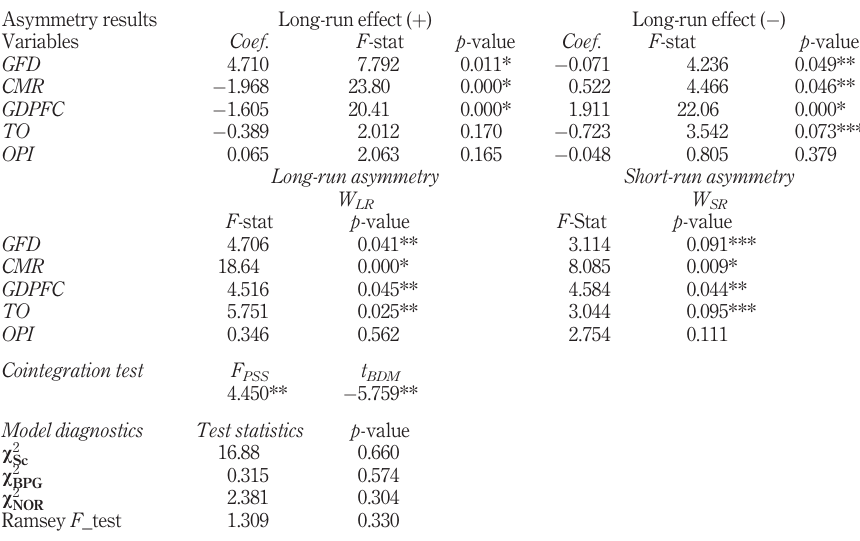
Table 5. Long and short-run asymmetry results (Model